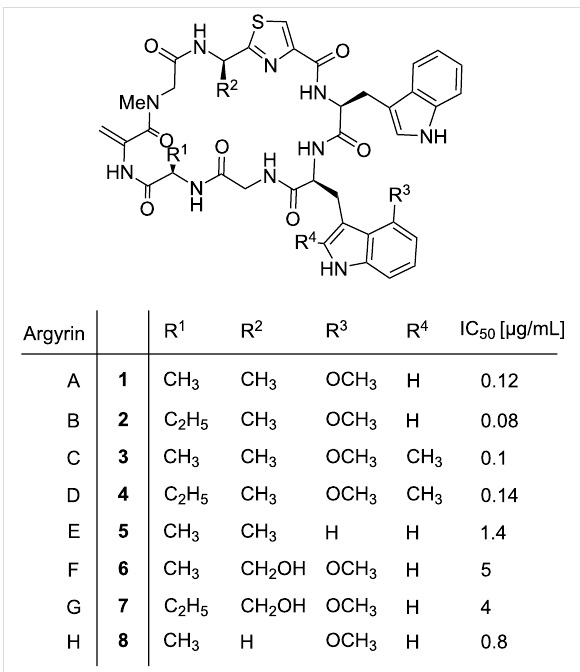
strains [2]. Unfortunately, most of these antibiotics rely